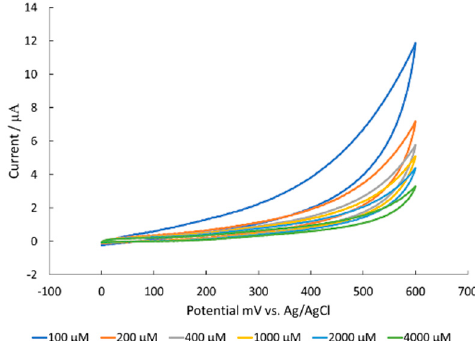
Figure 7. CV data of a serial dilution of creatine in 100 mM NaOH with a NiO modified glassy carbon electrode.